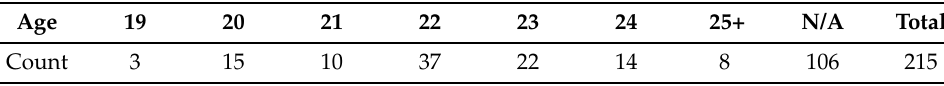
Table 3. Statistics about the age of the volunteers.